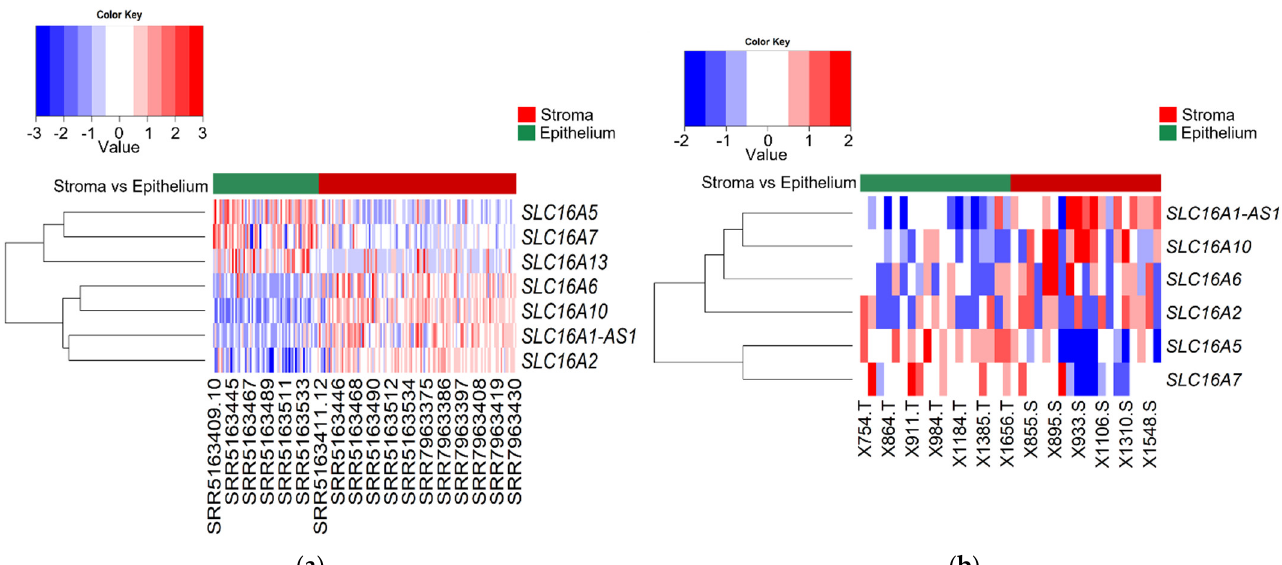
Figure A8. Heatmaps of ( a ) differentially expressed MCT genes that were clustered in the causal hypernetwork analysis of the GSE93326 dataset and ( b ) the same MCT genes in the Birnbaum (validation) dataset. The expression levels were normalised and scaled (z-scored) across 189 and 38 samples present in the GSE93326 and Birnbaum datasets, respectively. Red and blue colours indicate increased and decreased expression, respectively.